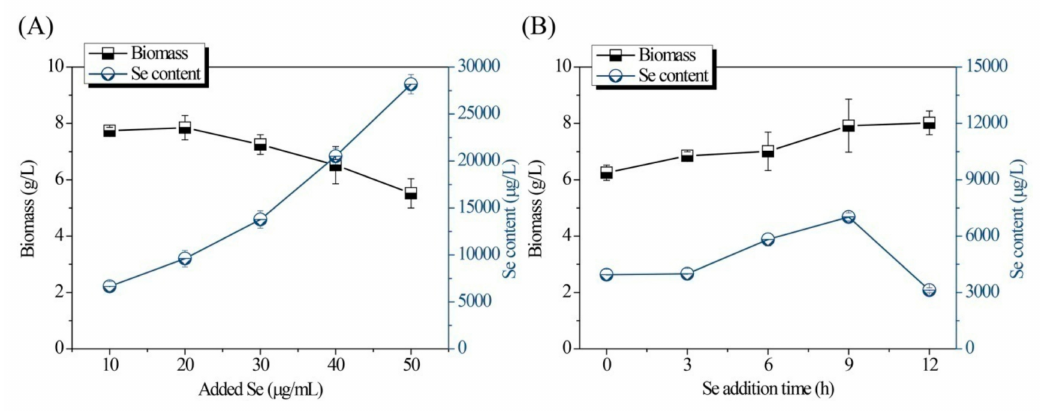
Figure 2. E ff ects of ( A ) Se concentration and ( B ) Se addition time on Se content and biomass of Se-enriched DB-yeast